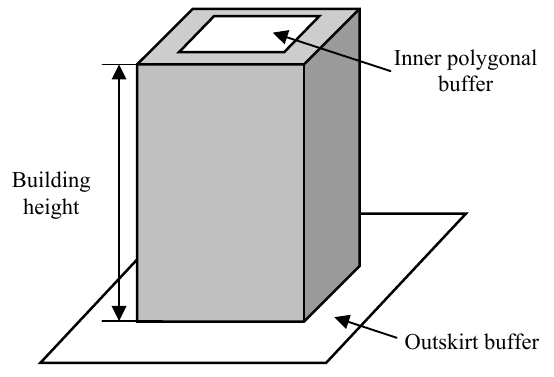
Figure 2. Illustration of building height